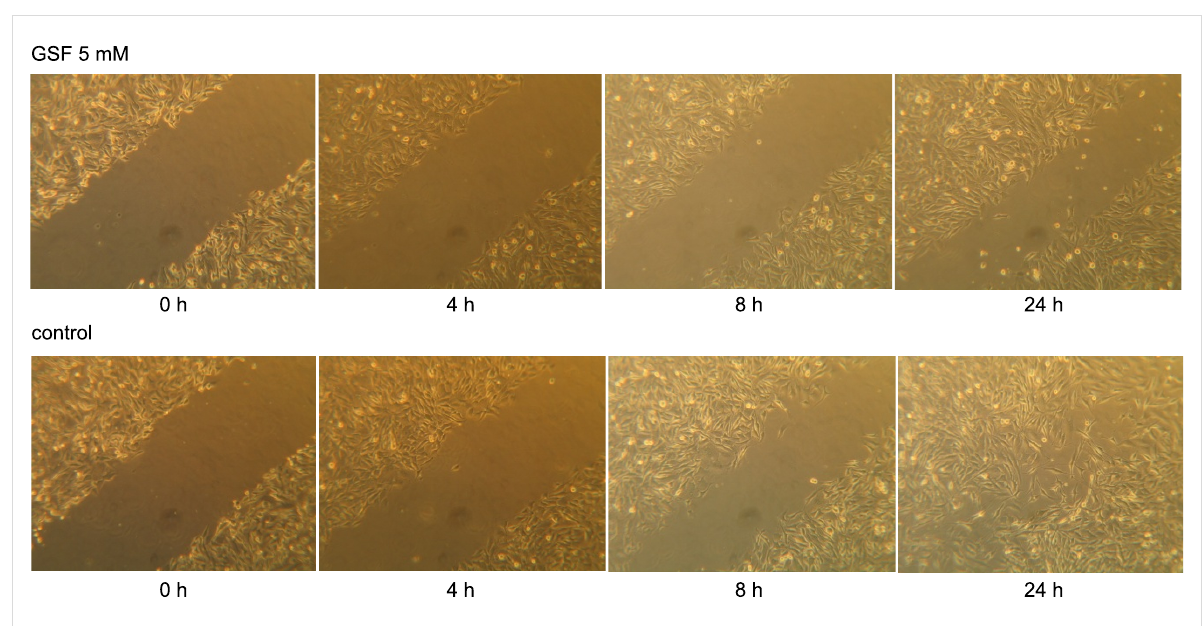
Figure 5: Intact cell monolayers of WM-115 cells in 12-well plates were wounded with a 100 µL pipette tip and washed three times with serum-free medium. Complete medium either containing 5 mM (4-{[( β -D-galactopyranosyl)oxy]methyl}furan-3-yl)methyl hydrogen sulfate (GSF) (upper row) or without GSF (lower row) was added to the wells, and cell migration into the wound was observed by microscopy after 0, 4, 8 and 24 h.